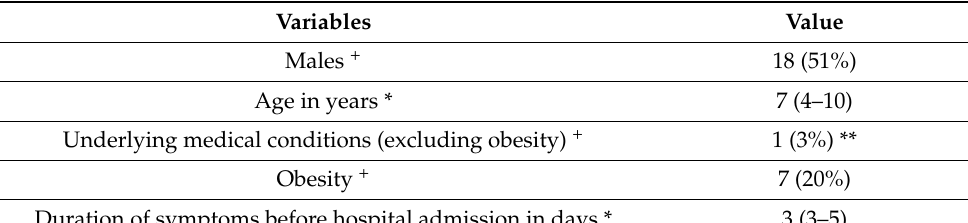
Table 1. Demographic, clinical, laboratory, and imaging characteristics and treatment in 35 patients with